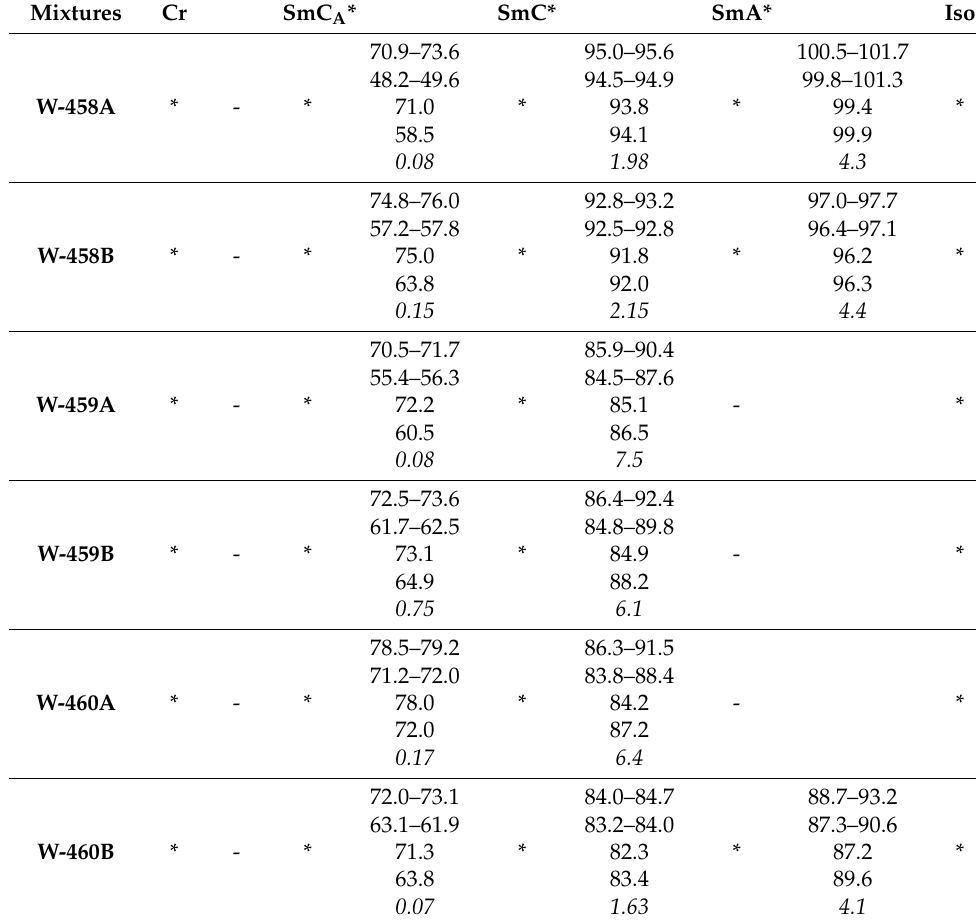
Table 4. The mesomorphic and thermodynamic properties of the prepared mixtures. (“*” means that the phase is observed and “-” means that it is not observed; The enthalpy is indicated by the